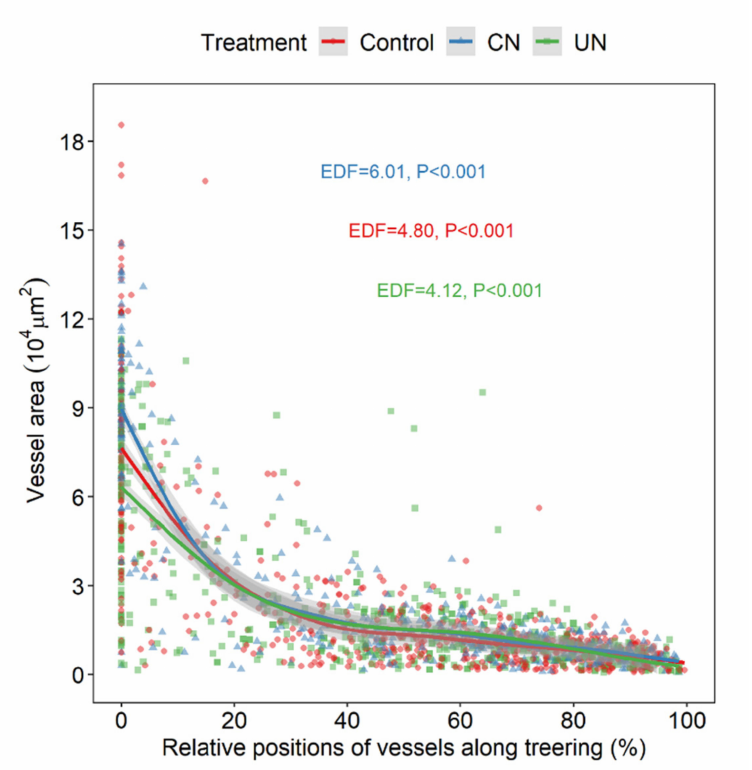
Figure 2. Relative position of vessels in Quercus variabilis Bl. along tree-ring in control (Control), canopy N addition (CN) and understory N addition (UN) treatments in 2013–2018. Note: Relative positions of vessels along tree-ring (values of x-axis) = distance of vessel to the start position of tree-ring/tree-ring width of the current year. EDF, the effective degrees of freedom (edf) estimated from generalized additive